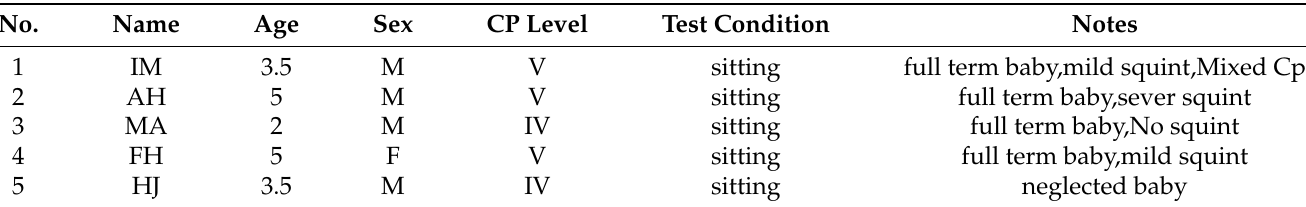
Table 1. Participants’ with CP